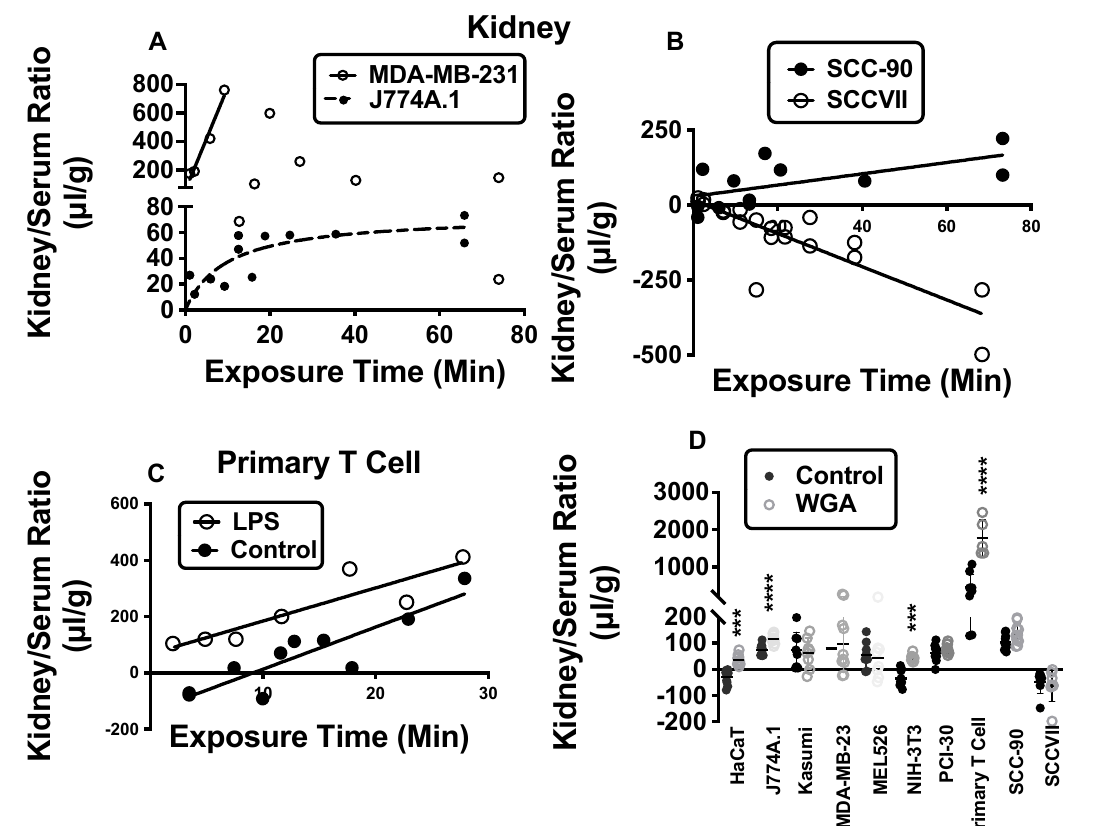
Figure 2. Kidney sequestration of exosomes. In ( A ), the two patterns of exosome sequestration for kidney: a hyperbolic pattern as exemplified by J774A.1 (n = 13) and an increase followed by decrease as exemplified by MDA-MB-231 N = 11). In ( B ), the pattern for SCC-90 (n = 13) and for SCCVII (which had negative values, n = 20) is shown. In ( C ), the increased sequestration of exosomes with LPS treatment for primary human T-cell exosomes (n = 13). In ( D ), four exosomes (HaCaT and J774A.1: n = 10 for all groups; NIH-3T3: n = 9 for control; n = 9 for WGA; Primary T cell: n = 8 for control, n = 5 for WGA) had sequestration that was increased by WGA (mean +/ − SE). See Figure S2 for exosomes not shown here. Regression analysis was used for panels ( A – C ) and t-test in panel ( D ). *** p < 0.001; **** p << 0.001.